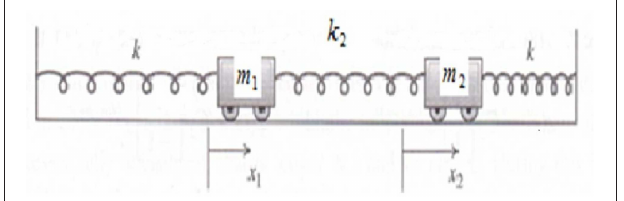
FIGURE 1 | Two coupled carts with different